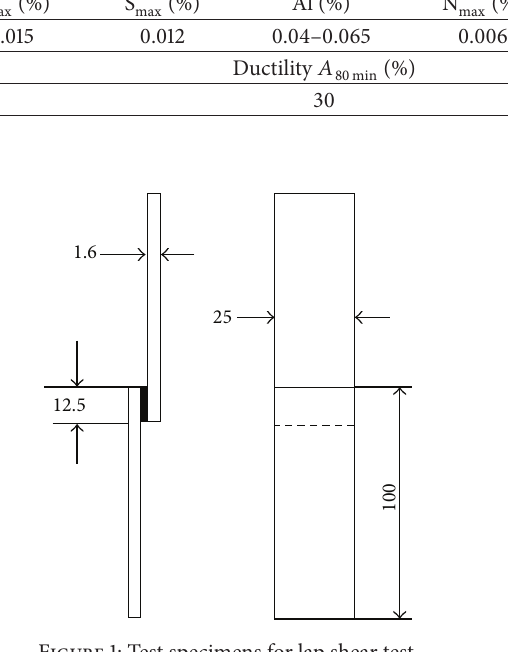
Figure 1: Test specimens for lap shear